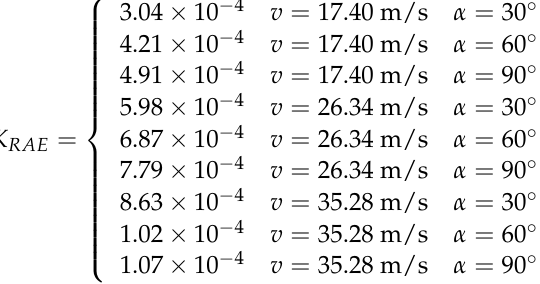
AE of glass specimens and impact time t